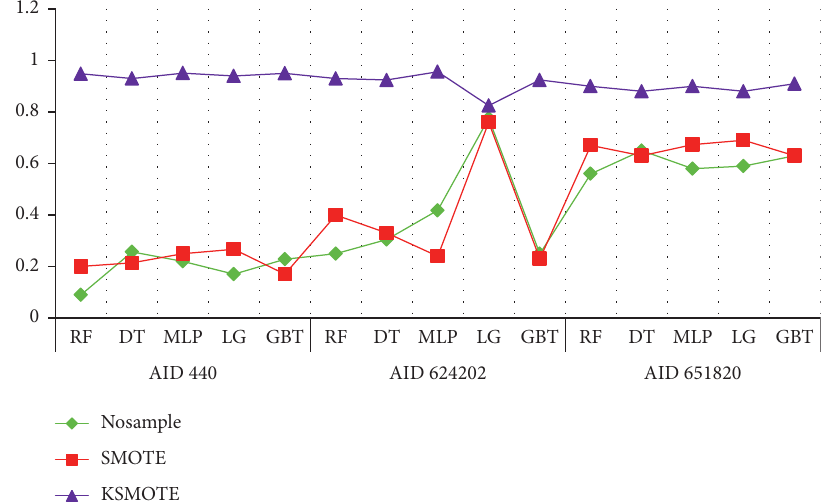
Figure 8: Sensitivity of all datasets for the fingerprint